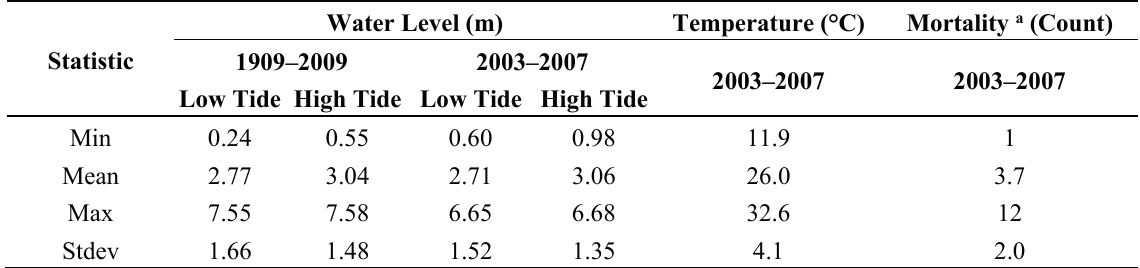
Table 1. Descriptive statistics for hydrometeorological and mortality data. Trend analysis of past water levels is performed using both low and high tide measurements for 1909–2009, while the remaining columns describe the water level, temperature and mortality data used to study a possible increase in fatalities following extremely low and high water